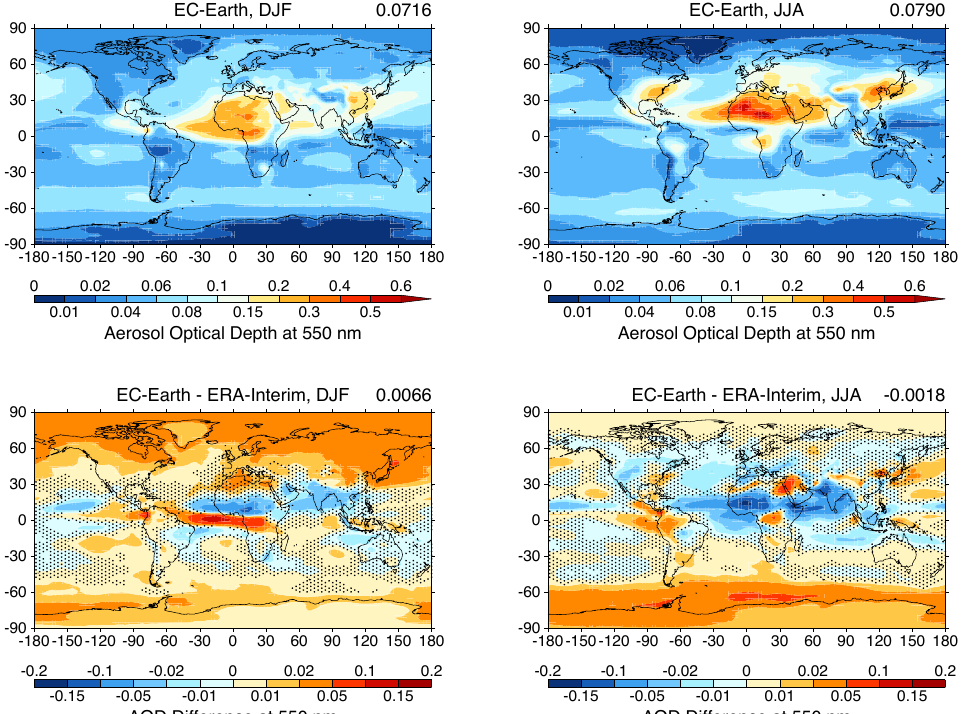
Figure 13. Aerosol optical depth at 550nm in the reference EC-Earth simulation (top) and the differences compared to the corresponding ERA-Interim simulation (bottom) for boreal winter (left) and boreal summer (right). The global mean values of the displayed fields are indicated at the top of each